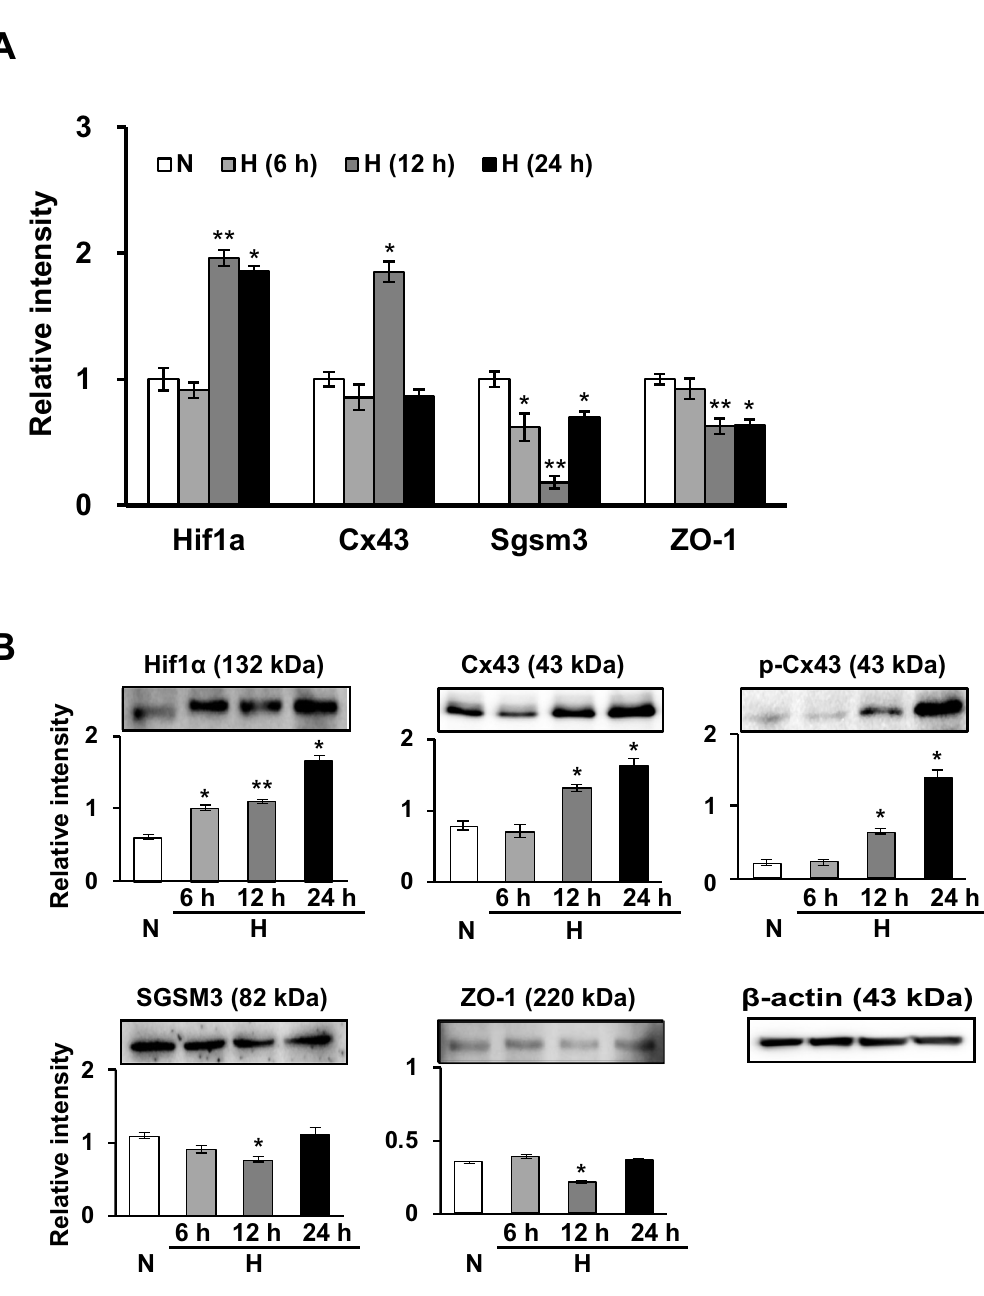
Fig 1. Time-dependent differential expression of gap junction factors (Cx43, ZO-1) and SGSM3 in normoxic and hypoxic conditions in rat MSCs as determined by qRT-PCR (A) and immunoblot analysis (B). All qRT-PCR values are shown as the normalized target gene expression level relative to the GAPDH transcript levels, and the data are representative of three independent experiments (A). Band intensity was measured as the area density and analyzed in ImageJ and relative intensity levels indicate protein levels normalized to the β -actin levels (B). Significant differences between the normoxia and hypoxia groups were determined via ANOVA, with p values indicated as � p < 0.01 and �� p < 0.001. N, normoxia; H, hypoxia; NC, negative control cells; KD, knockdown